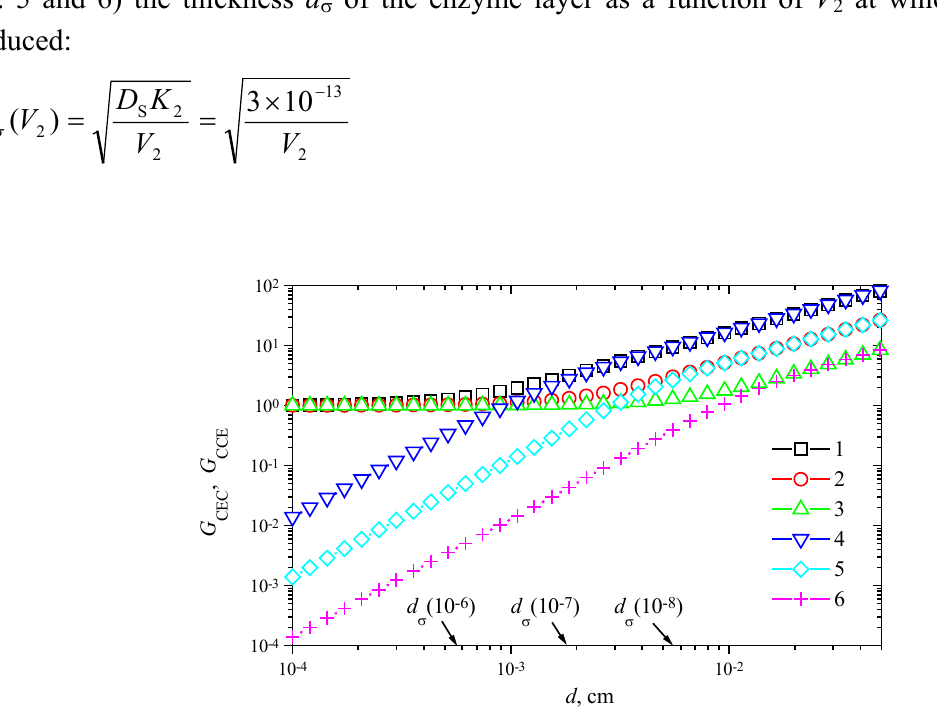
Figure 8 . The signal gains G maximal enzymatic rates V S = 0N